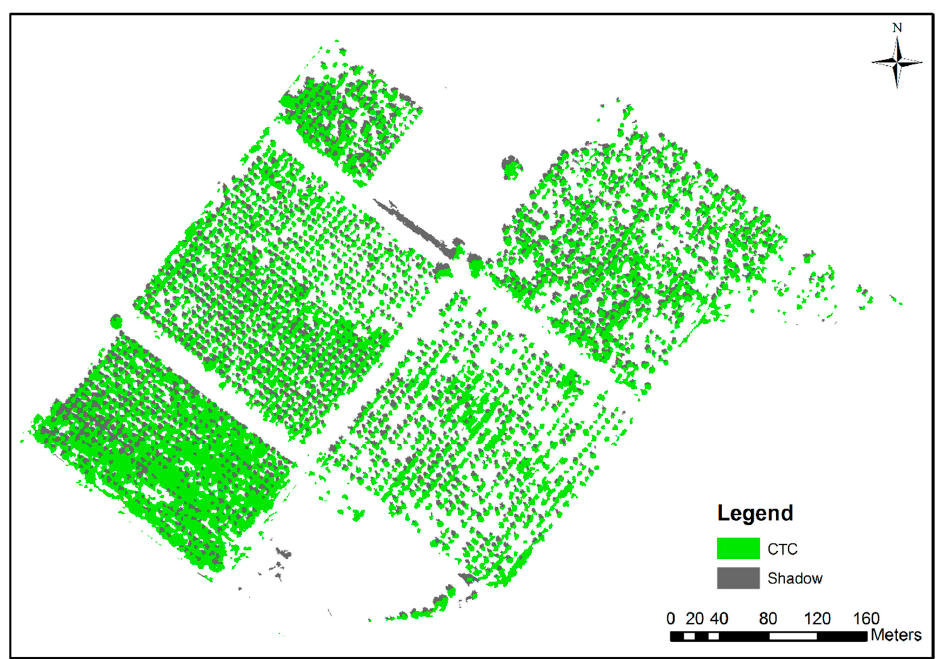
Figure 3. Map of the CTCs and shadows in the study area.